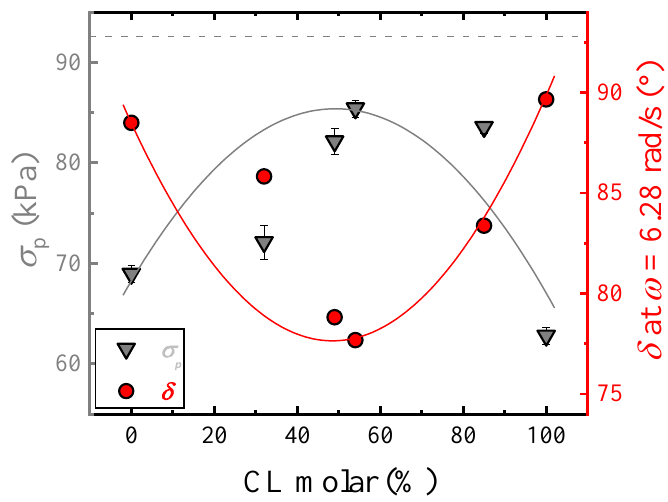
Figure 10. Stress at the plateau of stress-strain curve, σ p obtained at a debonding velocity of 0.314 mm/s ( ω = 6.28 s − 1 ) and phase angle δ obtained at ω = 6.28 rad/s, as a function of composition. The horizontal segmented line corresponds to the value of σ p for the Valco adhesive. The solid lines are guides to the eye.